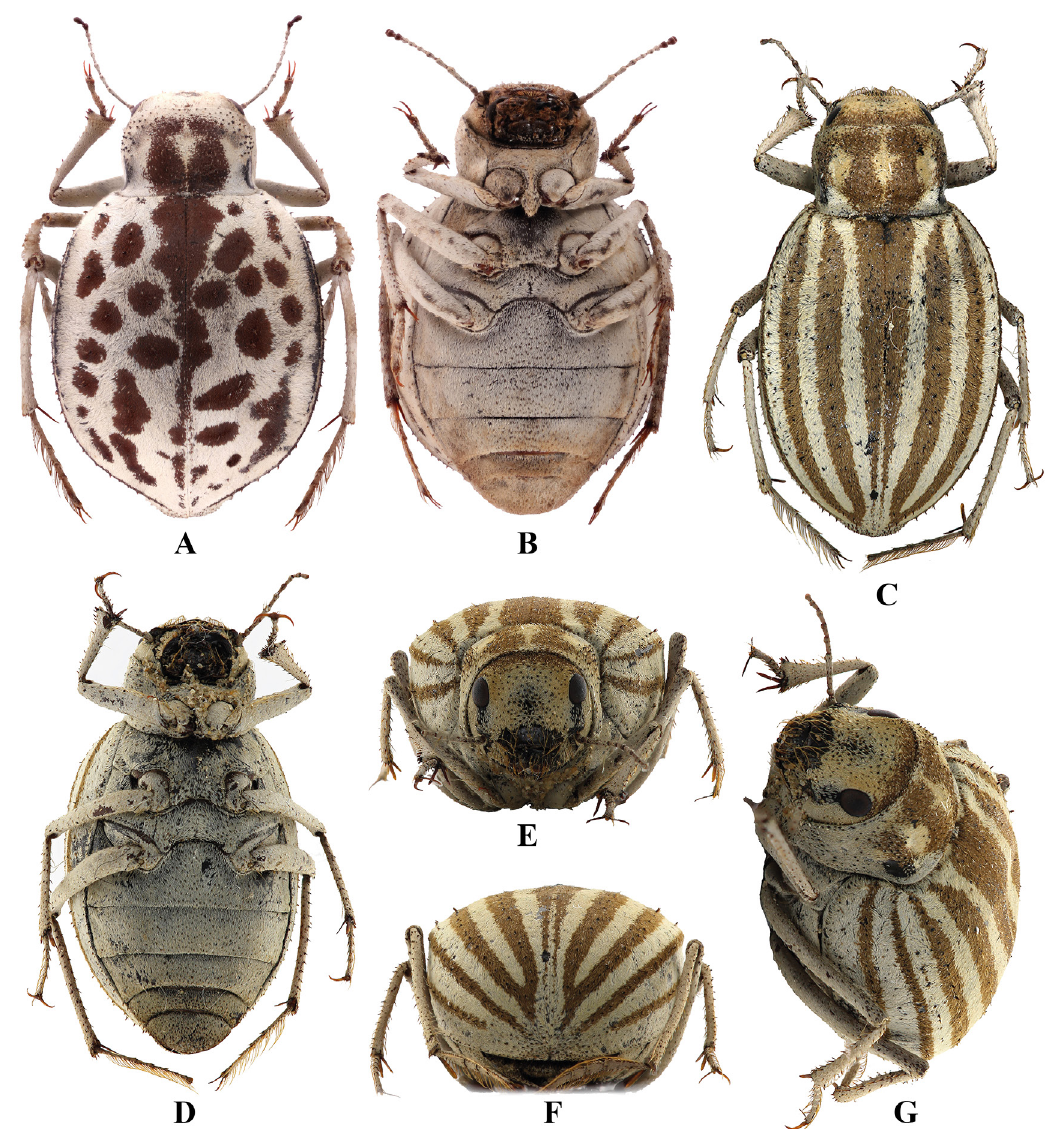
Fig. 3. Species of the genus Dietomorpha Kühnelt, 1957, habitus. A . D. pardalis Kühnelt, 1957, ♂ (ZIN), dorsal view. B . Ditto, ventral view. C . D. gonzalesi S. Chigray & Nabozhenko sp. nov., ♀, holotype (MNHP), dorsal view. D . Ditto, ventral view. E . Ditto, anterior view. F . Ditto, posterior